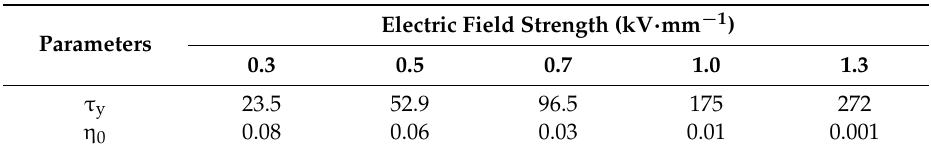
Table 2. Optimized values of parameters for the Bingham model for the MCC ER fluid is Figure 6a (reproduced from